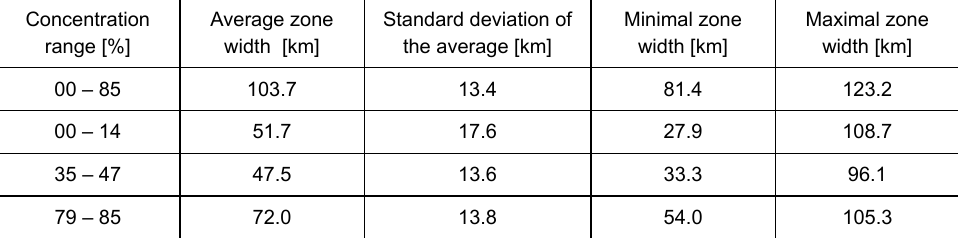
Table 1. The bandwidth occupied by selected boundaries at designated ranges of MIZ zone Concentration range